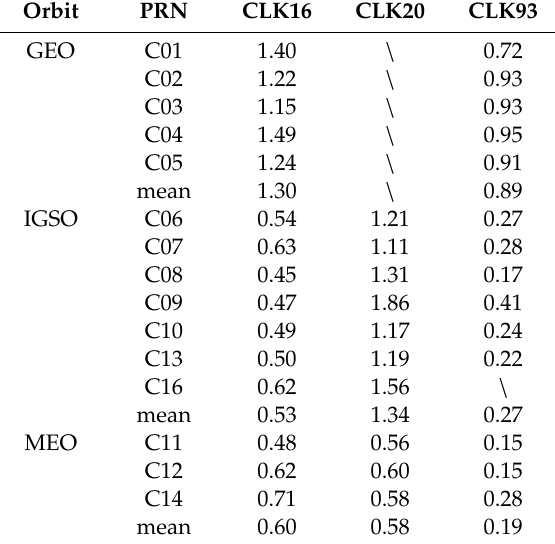
Table 3. Precision of the real-time BDS clock products for each satellite (units: ns). CLK20 does not provide GEO clock